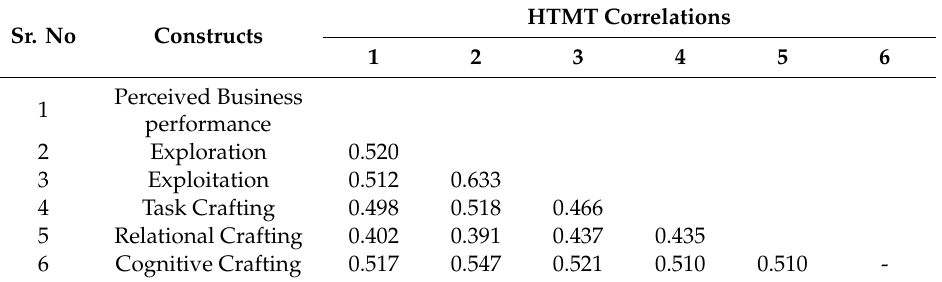
Table 2. Results of discriminant